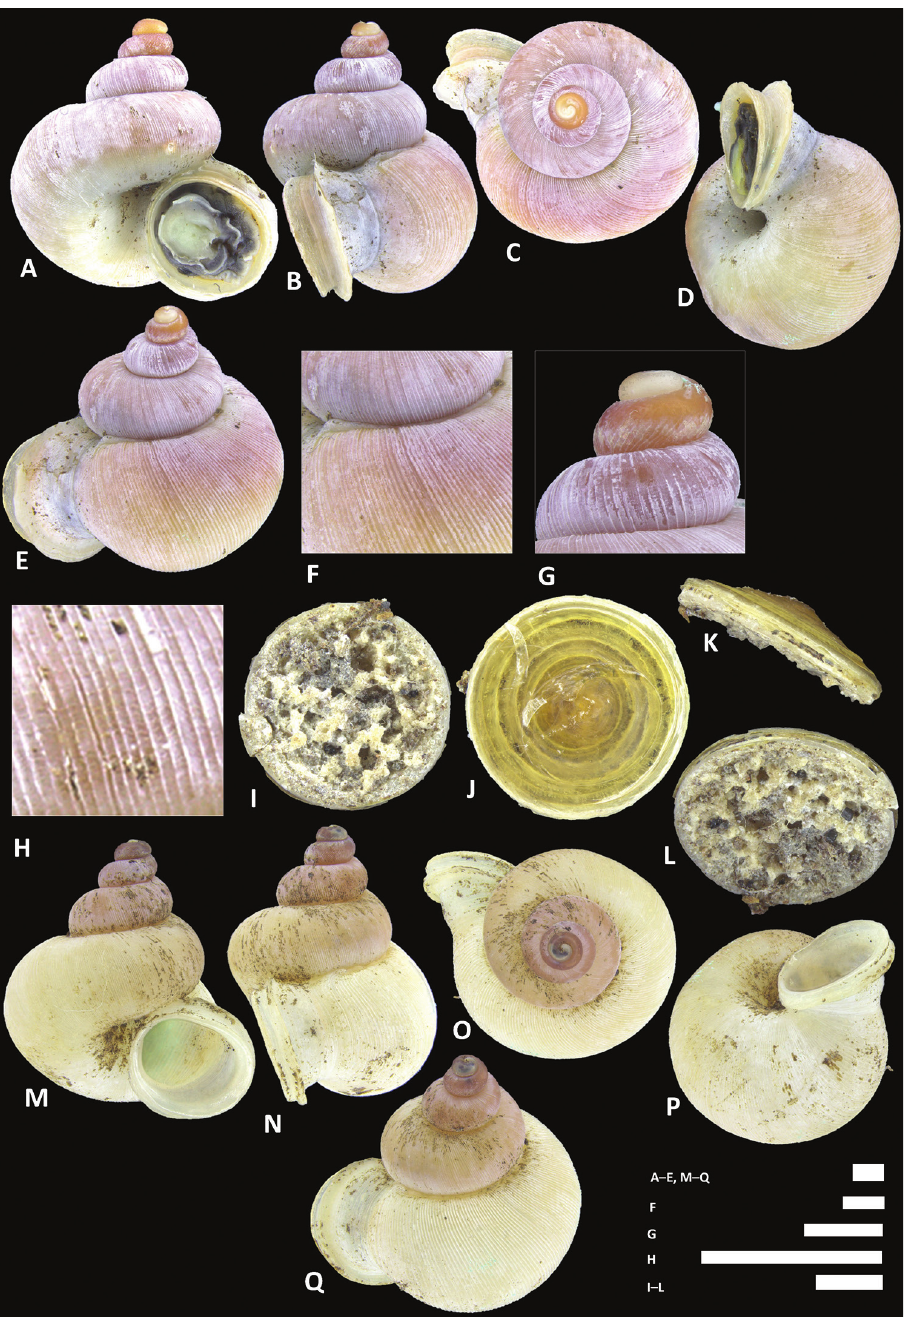
Figure 17. Alycaeus gibbosulus Stoliczka, 1872. A–E Shell of BOR/MOL 8525 F–H Close up of shell of BOR/MOL 8525 I–L Operculum of BOR/MOL 8525 M–Q Shell of BOR/MOL 12960. Scale bars: A–Q 1 mm. All photographs by Junn Kitt